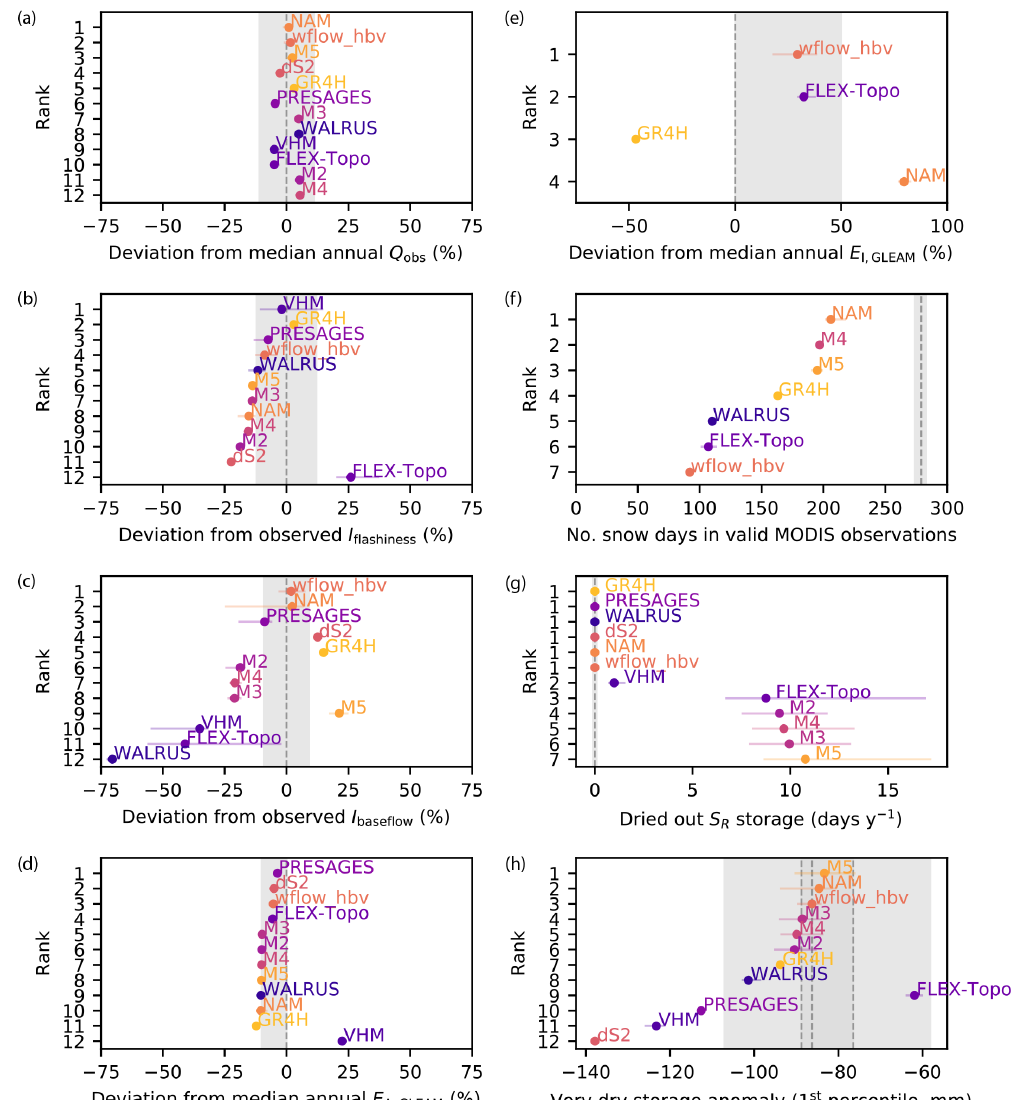
Figure 9. Ranking and evaluation of model behavior for a selection of criteria based on observed streamflow, remote-sensing data and expert knowledge. The grey shaded areas are soft indications of more plausible behavior based on uncertainty estimates and expert knowledge. Model ranks as a function of the (a) deviation from observed median annual streamflow; (b) deviation from the flashiness index; (c) devi- ation from the baseflow index; (d) deviation from median annual GLEAM actual evaporation; (e) deviation from median annual GLEAM interception for models with a separate interception module; (f) number of days with snow cover for valid MODIS observations between 2001 and 2017 for models with a snow module; (g) annual number of days when the root-zone storage is dry (filled with less than 1% of its capacity); (h) deviation from the 1st percentile of GRACE total storage anomalies for the three centers. The error bars show the 25th–75th range across the ensemble of feasible parameter sets. Results are for the Ourthe catchment upstream of Tabreux, except for the snow